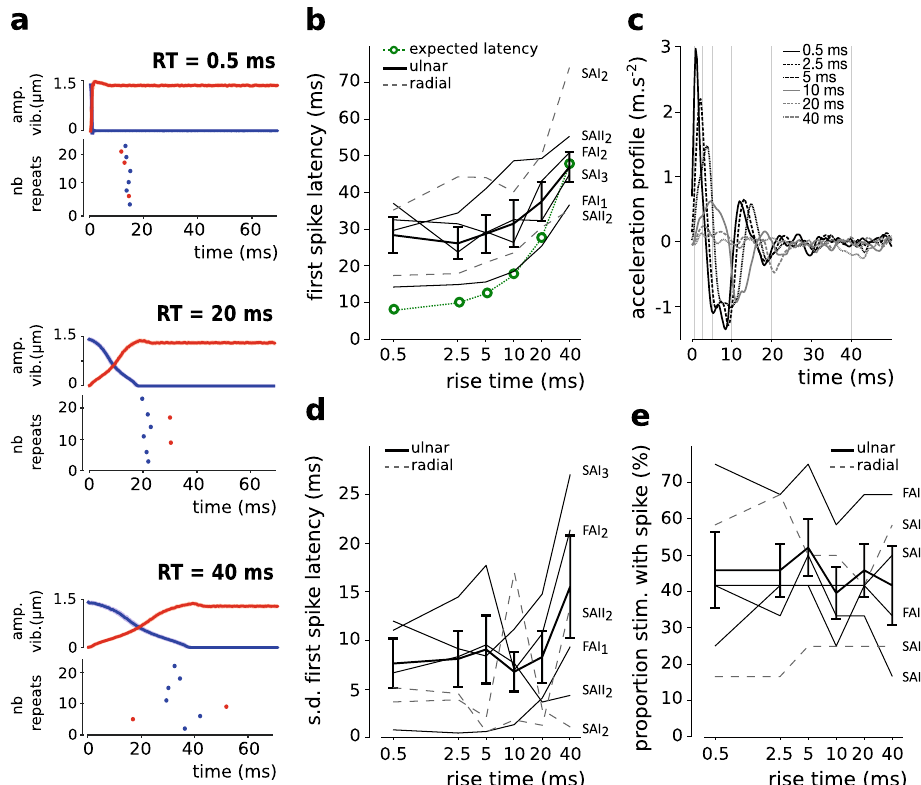
Figure 3. Rise time manipulation. ( a ) Profiles of ultrasonic vibration (average and s.d. traces), and the corresponding raster plots are shown for FAI 1 for three rise time conditions (0.5, 20 and 40 ms). Colours illustrate the friction condition, i.e. increase in friction over time (which corresponds to a decrease in ultrasonic vibration value, blue) or decrease (red). Dot filling represents the sliding direction, with filled dots for the ulnar direction and unfilled dots for the radial direction. Note that the unit presented FAI 1 does not fire in the radial direction. ( b ) First spike latency as a function of the rise time conditions. Individual traces (ulnar and radial) and group results (ulnar only, N = 4). The error bars represent the standard error of the mean (s.e.m). In green, an estimation of the expected first spike latency. ( c ) Group acceleration profile. Individual acceleration curves were normalized as a function of the friction condition (increase or decrease) and of the sliding direction. They were then averaged for each participant, and are here presented as an average obtained for the group (N = 6). The grey grid in background shows the expected stimulation time offsets. Acceleration peaks pointing upwards are revealed especially for the short rise time conditions, at approximately the expected moment, and, their amplitude seems to increase the shorter the rise time. Downwards peaks are also seen around 10, 20 and 40 ms. This profile confirms that the programmed events occurred at the expected moments in time. ( d ) Standard deviation of the first spike latency as a function of the rise time conditions. The error bars represent the s.e.m. ( e ) Proportion of stimulations with spike as a function of the rise time conditions. The error bars represent the